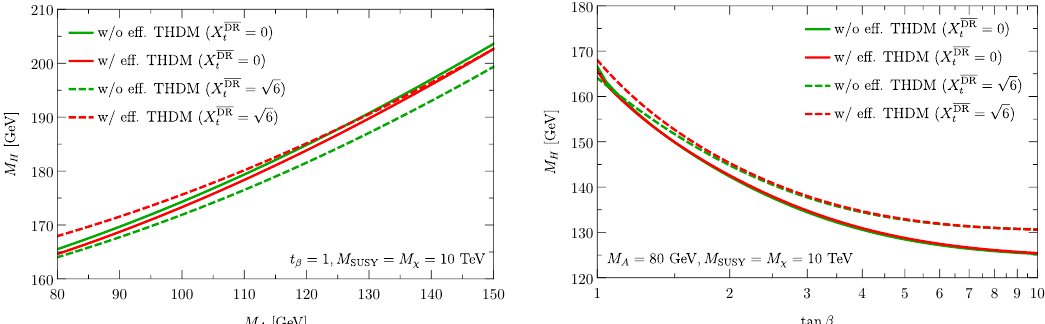
Figure 9 . Left: M H as a function of M A for tan (cid:12) = 1. Right: M H as a function of tan (cid:12) for M A = 80 GeV. The results of FeynHiggs without e(cid:11)ective THDM using the non-degenerate O ( (cid:11) 2 threshold correction (green) and with e(cid:11)ective THDM (red) are compared. X DR p and X DR =M SUSY = 6 t